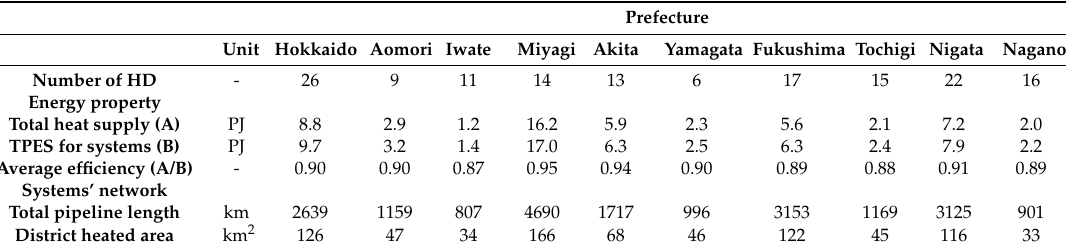
Table 3. Analytical result of DHS designs by